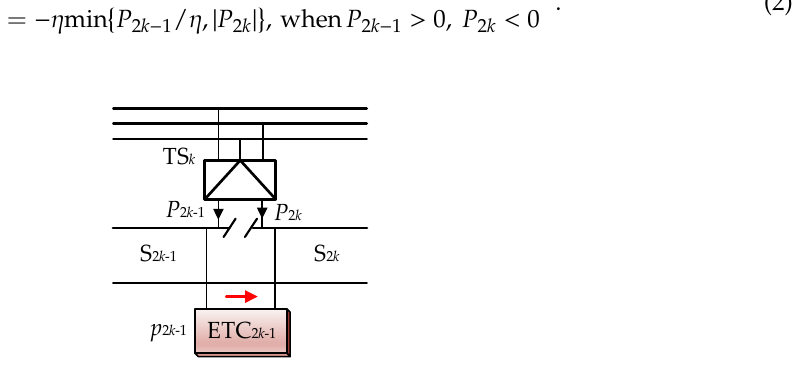
Figure 6. ETC 2 k − 1 transfers the regenerative braking power to adjacent power supply sectors in traction substation (TS) k .